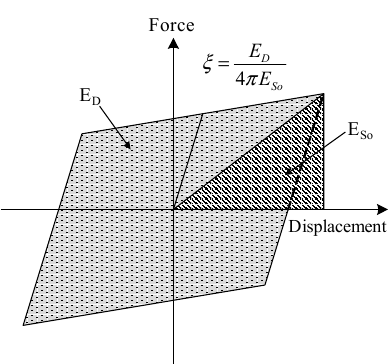
Figure 8. Estimation of equivalent damping ratio.